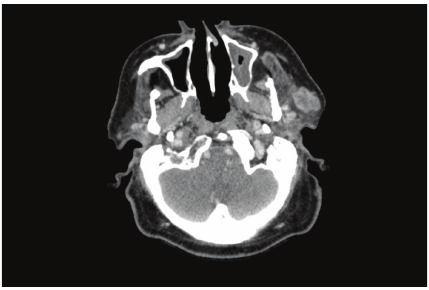
Figure 5: Preoperative CT showing parotid gland lesion.